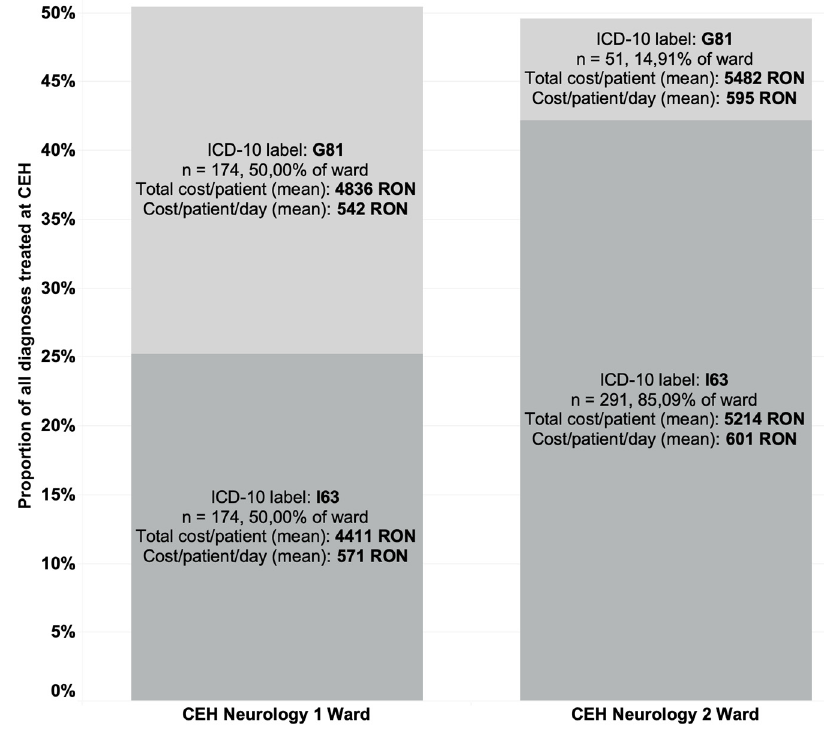
Figure 2. The difference in total cost and codification across G81 and I63 categories and CEH neurology wards.